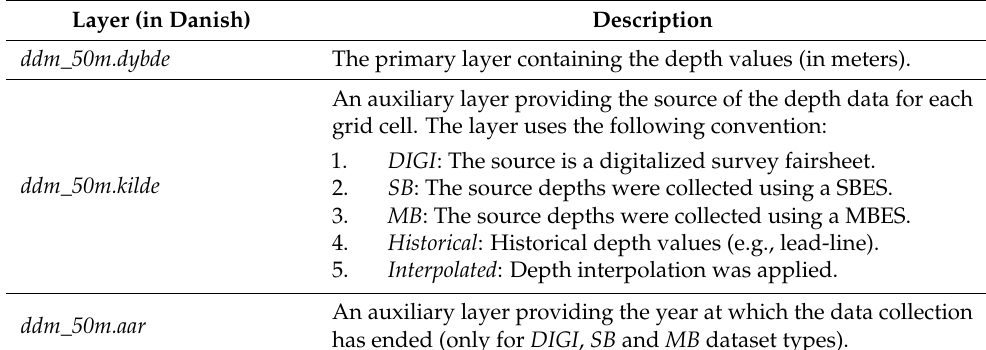
Table 1. Layers extracted from the finalized DBM for public release. Layer (in Danish)